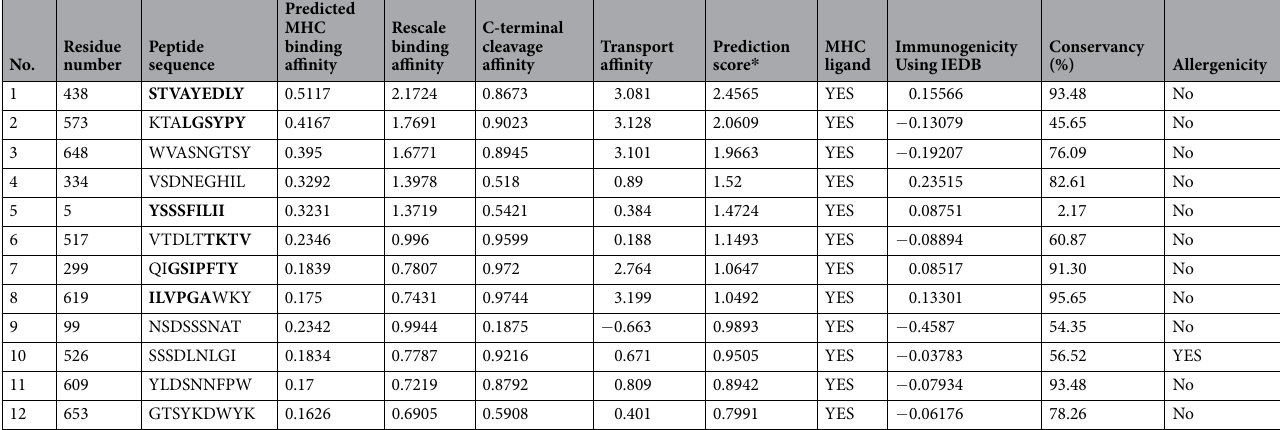
Table 7. Predicted CTL epitopes. Residues in Bold indicate that were also predicted as antigenic sites in linear B-cell